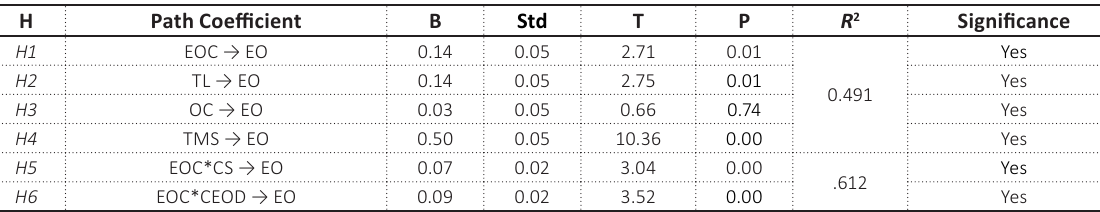
Table 4. Result of hypotheses testing